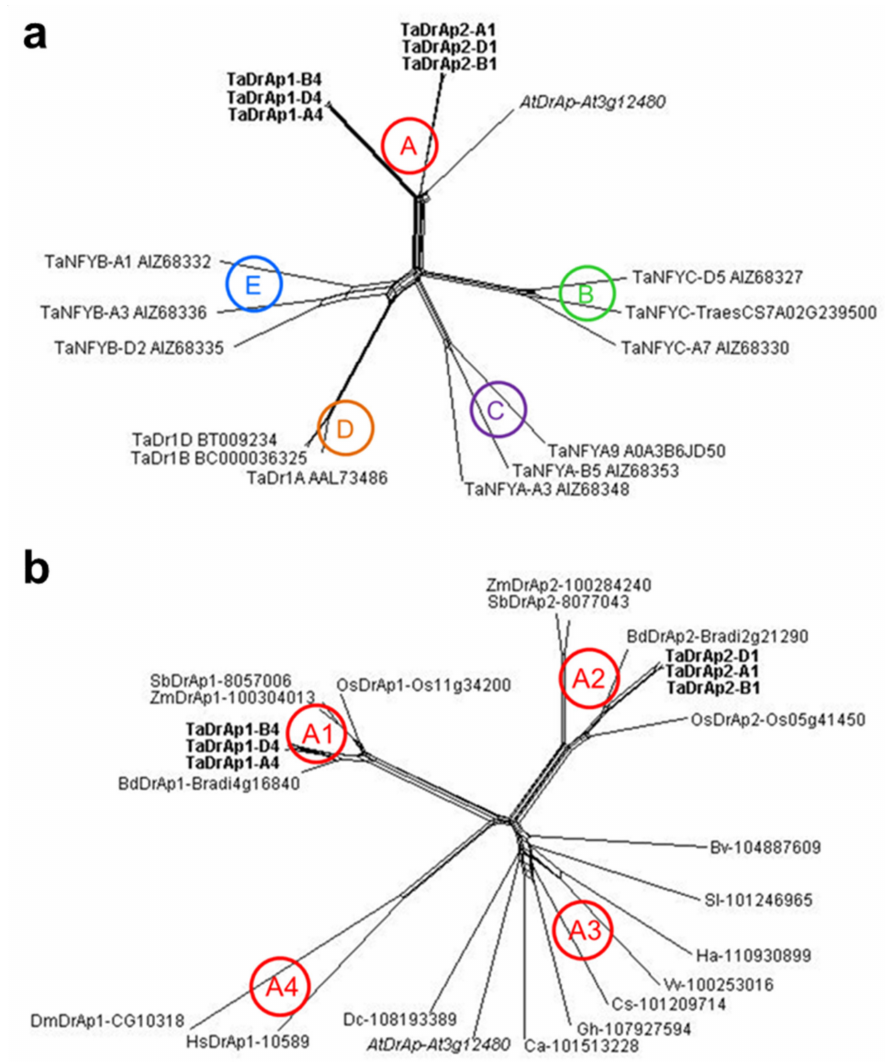
Figure 2. Molecular phylogenetic dendrograms prepared using the SplitsTree4 program for amino acids in two down-regulator associated proteins, DrAp1 and DrAp2, and down-regulator Dr1 and three groups of transcription factors Nuclear factor Y (NF-Y) in wheat ( a ); and extended clade A for DrAp1 and DrAp2 in monocot and dicot plant species and references ( b ). Target proteins are indicated in bold. Sequences were retrieved for bread wheat, Ta ( Triticum aestivum ), from the Gramene and KEGG databases; for rice, Os ( Oryza sativa ), from the rice genome annotation website; for Bd ( Brachypodium distachyon ), from the Brachypodium website; for At ( Arabidopsis thaliana ), indicated in italics as reference plant species, from the TAIR website; and for all other species from the KEGG database, with the following abbreviations in clockwise order: Sb, Sorghum bicolor ; Zm, Zea mays ; Bv, Beta vulgaris ; Sl, Solanum lycopersicum ; Ha, Helianthus annuus ; Vv, Vitis vinifera ; Cs, Cucumis sativus ; Gh, Gossypium hirsutum ; Ca, Cicer arietinum ; Dc, Daucus carota ; Hs, Homo sapiens ; Dm, Drosophila melanogaster . All analyzed sequences are presented in Supplementary Material File